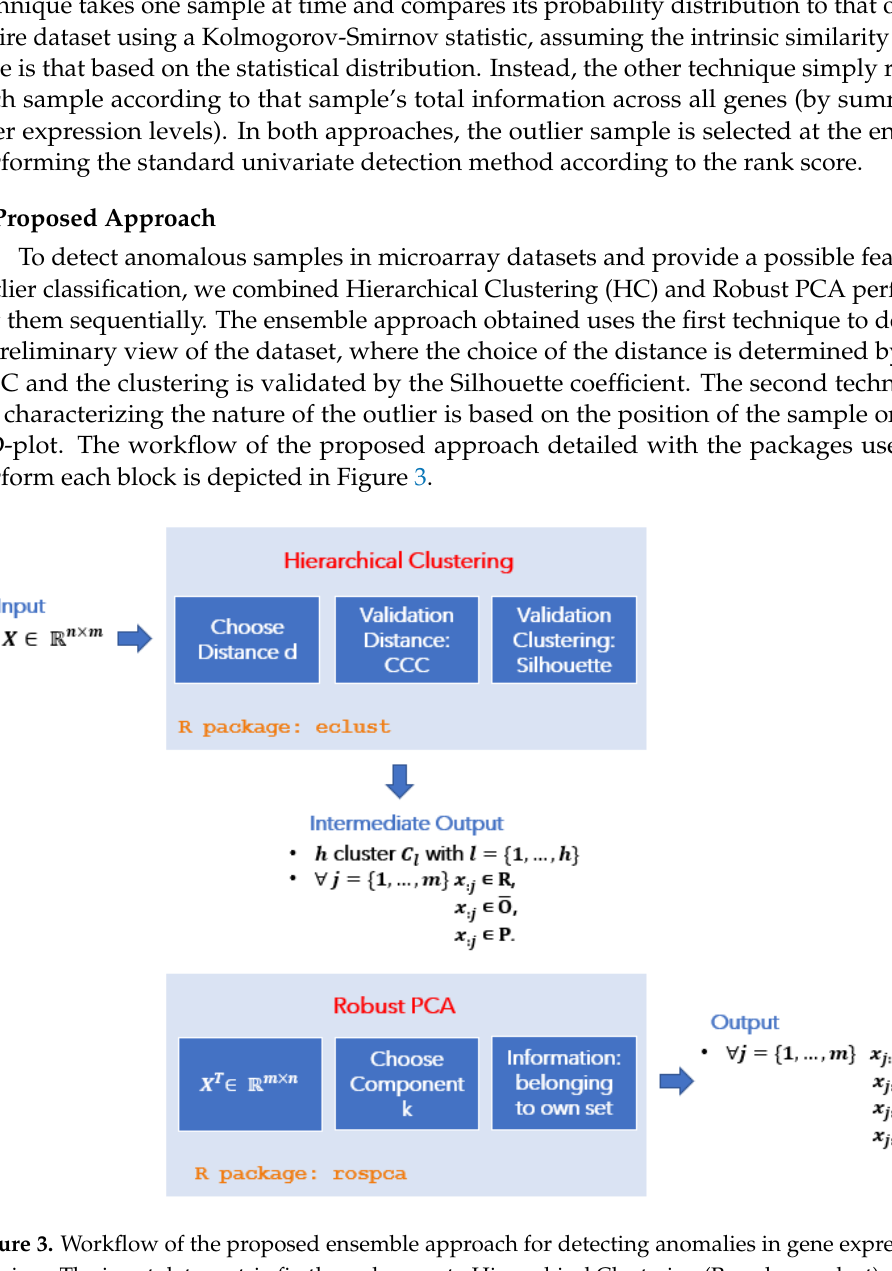
Figure 3. Workflow of the proposed ensemble approach for detecting anomalies in gene expression matrices. The input data matrix firstly undergoes to Hierarchical Clustering (R package eclust) which provides the intermediate output. Then, Robust PCA (R package rospca) is applied to derive the final characterized nature of anomalies as described in Algorithm 1. The labels reported in the figure referred to: R = Regular Observation, O = Outier, O = Orthogonal Outlier, B = Bad Leverage Point, A = Alert Sample